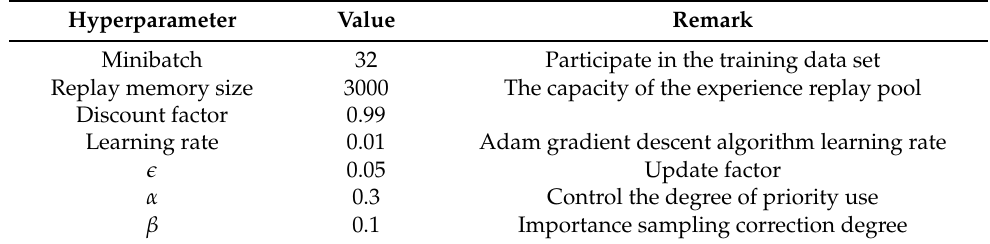
Table 2. Algorithm Hyperparameter Settings In Mountaincar Environment.